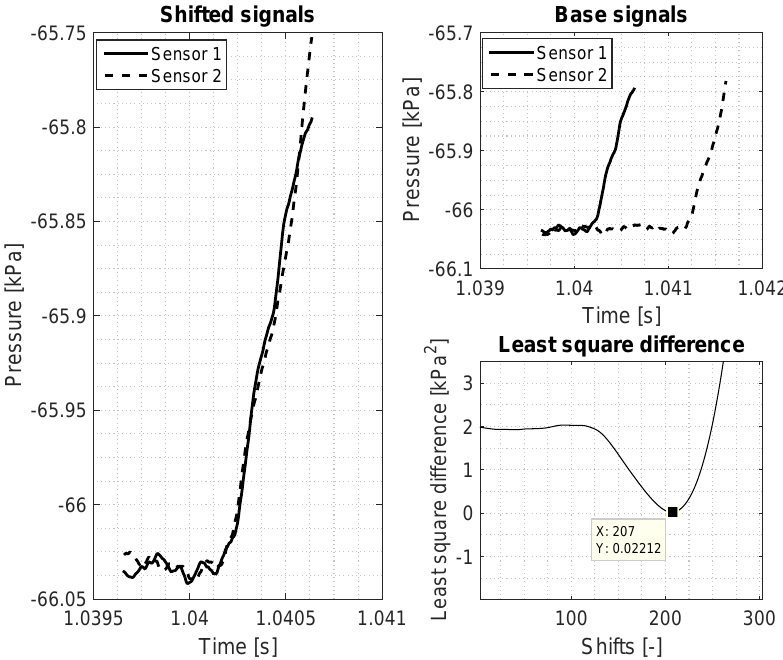
Figure 8. Least square analysis on time-of-arrival of negative pressure waves originating from leak position